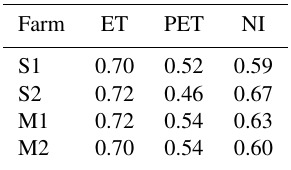
Table 5. KGE values of different covariates for different